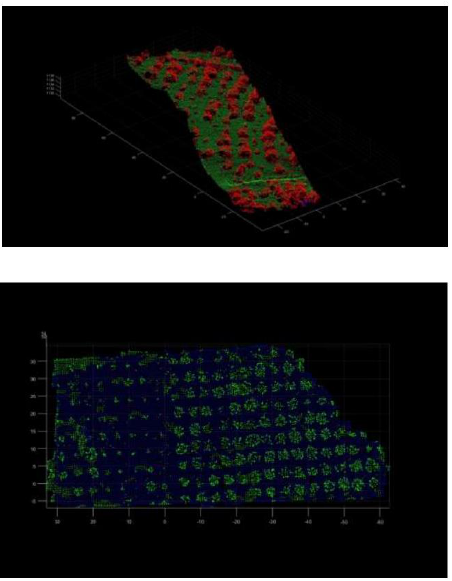
Figure 10. Region-base algorithm